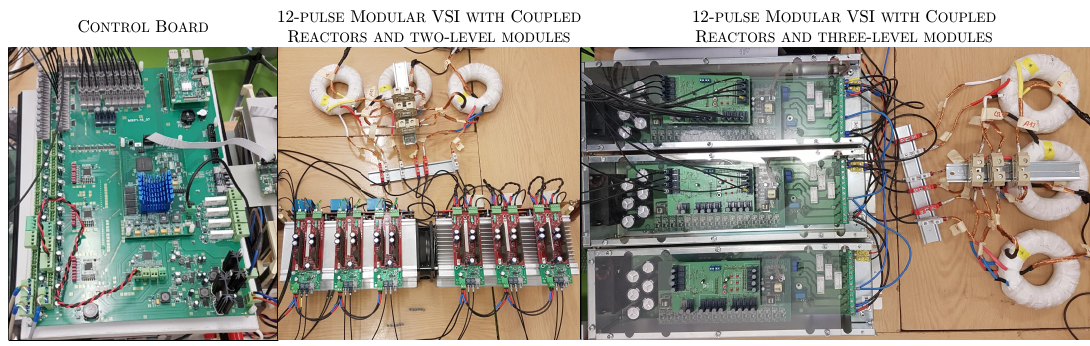
Figure 12. The laboratory